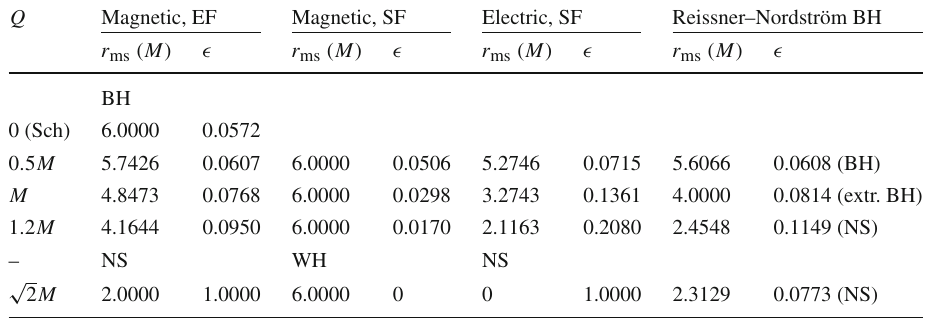
Table 1 The r ms and the efficiency (cid:8) for GMGHS